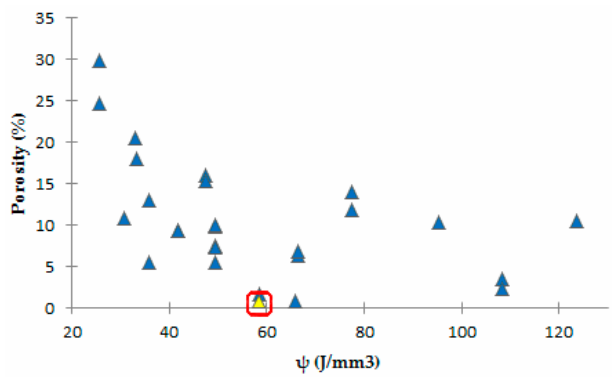
Figure 12. Porosity variation versus volumetric energy density. The highlighted point represents the lowest porosity level obtained for the SLM processing of AlSi10Mg powders.